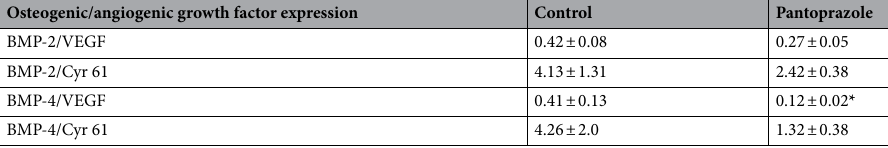
Table 1. Ratio of osteogenic to angiogenic growth factor expression within the callus tissue of controls and pantoprazole-treated animals at 2 weeks after fracture healing. All data are mean ± SEM; *p < 0.05 vs. control.